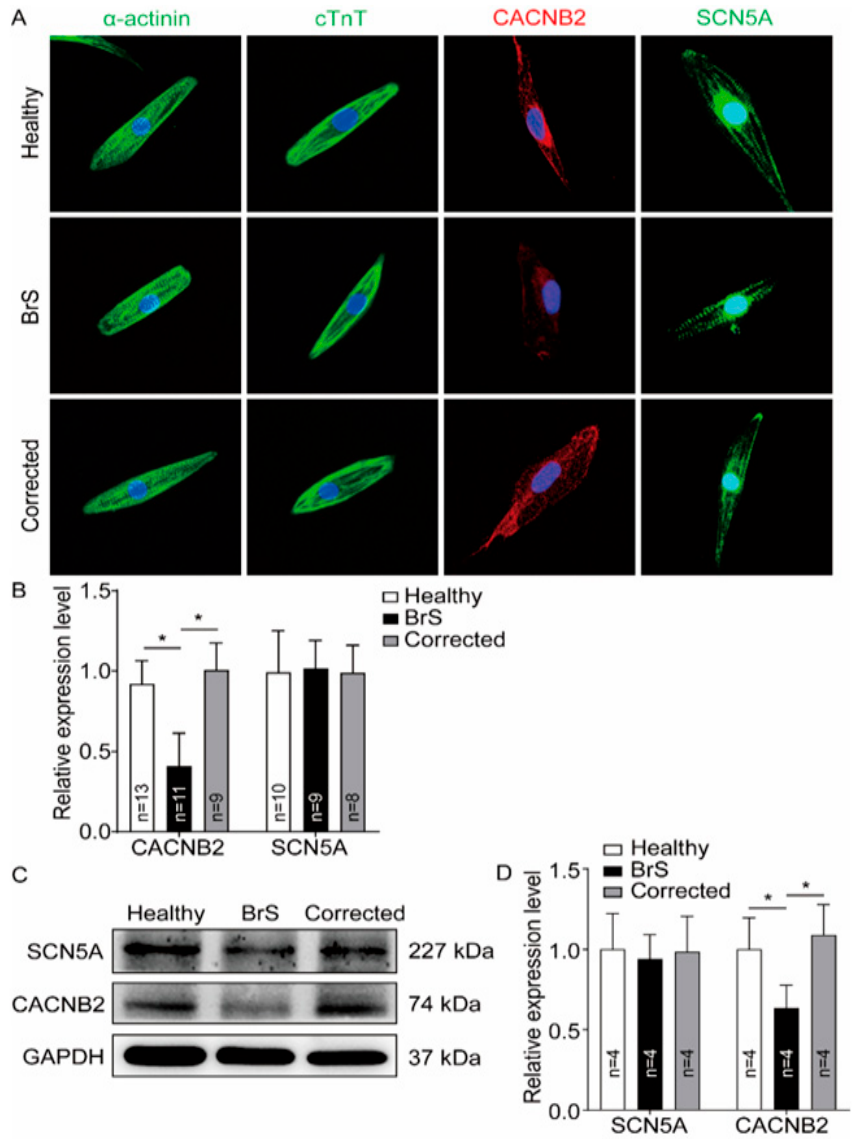
Figure 3. Reduction of CACNB2 protein expression level in hiPSC-CMs from the BrS-patient. Western blot and immunostaining analyses were performed to examine the protein levels of CACNB2 in hiPSC-CMs from healthy donor (Healthy), the patient (BrS) and isogenic control cell line (Corrected). ( A ) Representative immunostaining images. ( B ) Statistical analyses of fluorescence intensity from immunostained cells. ( C ) Representative examples of Western blots of cell lysates from healthy donor cell line (healthy), the patient (BrS) and the CRISPR/Cas9-corrected (Corrected) hiPSC-CMs. ( D ) Statistical analyses of relative expression levels of SCN5A and CACNB2 from Western blot experiments. Data were shown as mean ± standard deviation (SD). Numbers given represent the number of cells ( B ) or experiments ( D ). * p < 0.05 versus healthy analyzed by one-way analysis of variance (ANOVA) with Holm–Sidak post-test.